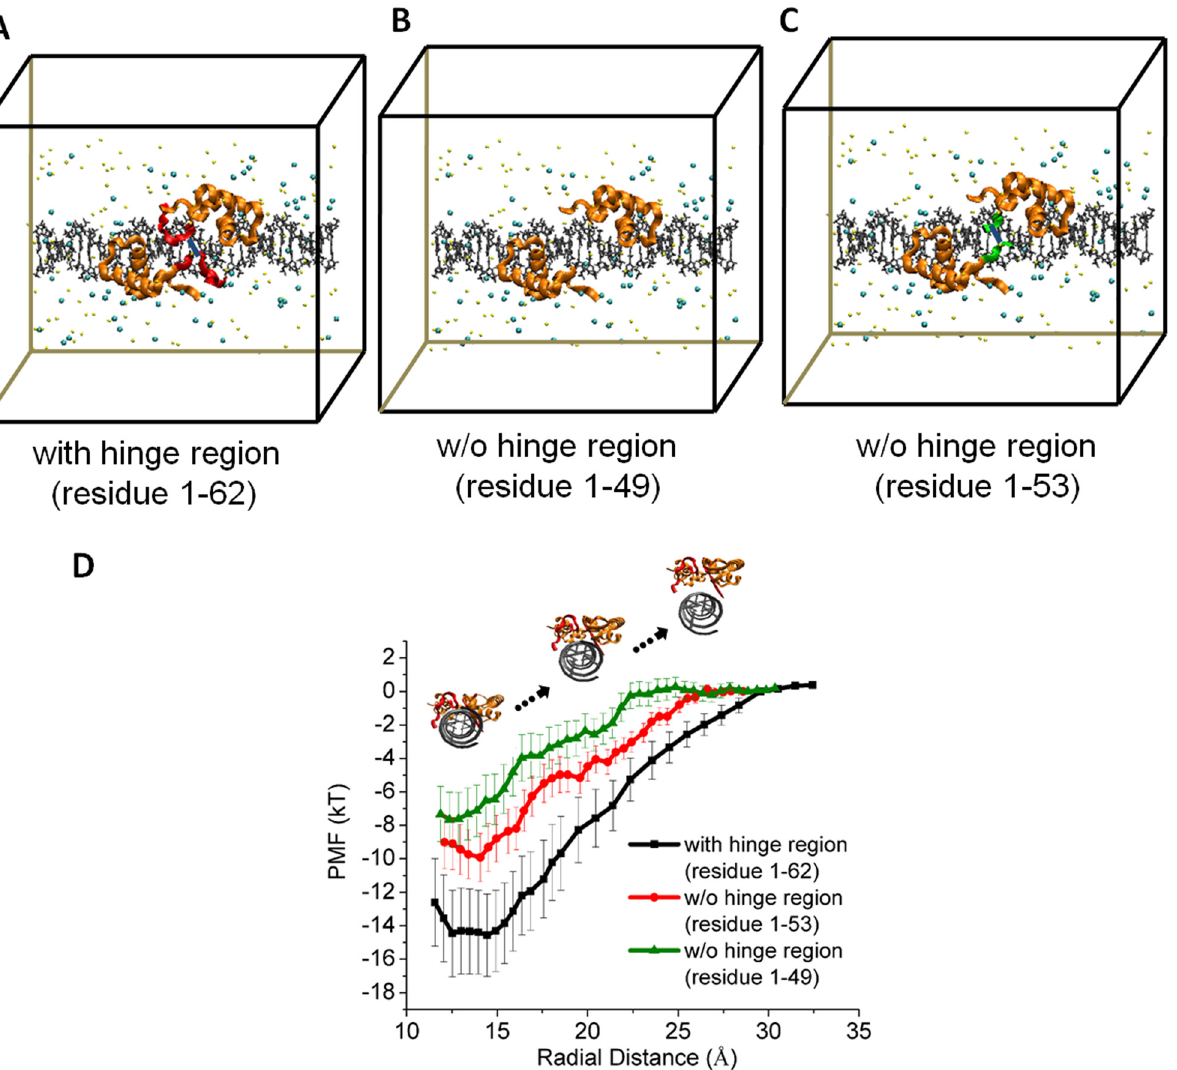
Fig 2. The micro-dissociation PMF of the LacI from nonspecific DNA. (A) PMF during the micro-dissociation process of the LacI from DNA both with the hinge region and without the hinge region. The PMF of LacI Δ 1 – 62 micro-dissociation from DNA is shown by the black curve; The PMF of LacI Δ 1 – 53 from DNA is shown by the red curve; The PMF of LacI Δ 1 – 49 from DNA is shown by the green curve. (B) The initial simulation system containing the LacI Δ 1 – 62, DNA and salt ions. Water molecules are not shown. The DNA (gray) is shown in licorice representation; residues 1 – 49 (orange) are shown in ribbons; residues 50 – 53 (green) are shown in ribbons; residues 54 – 62 (red) are shown in ribbons; sodium and chloride ions are shown as yellow and cyan spheres; (C) The initial simulation system containing the LacI Δ 1 – 49, DNA and salt ions; (D) The initial simulation system containing the LacI Δ 1 – 53, DNA and salt ions. The water box in the Fig 2 is schematic and does not reflect the real size of simulation